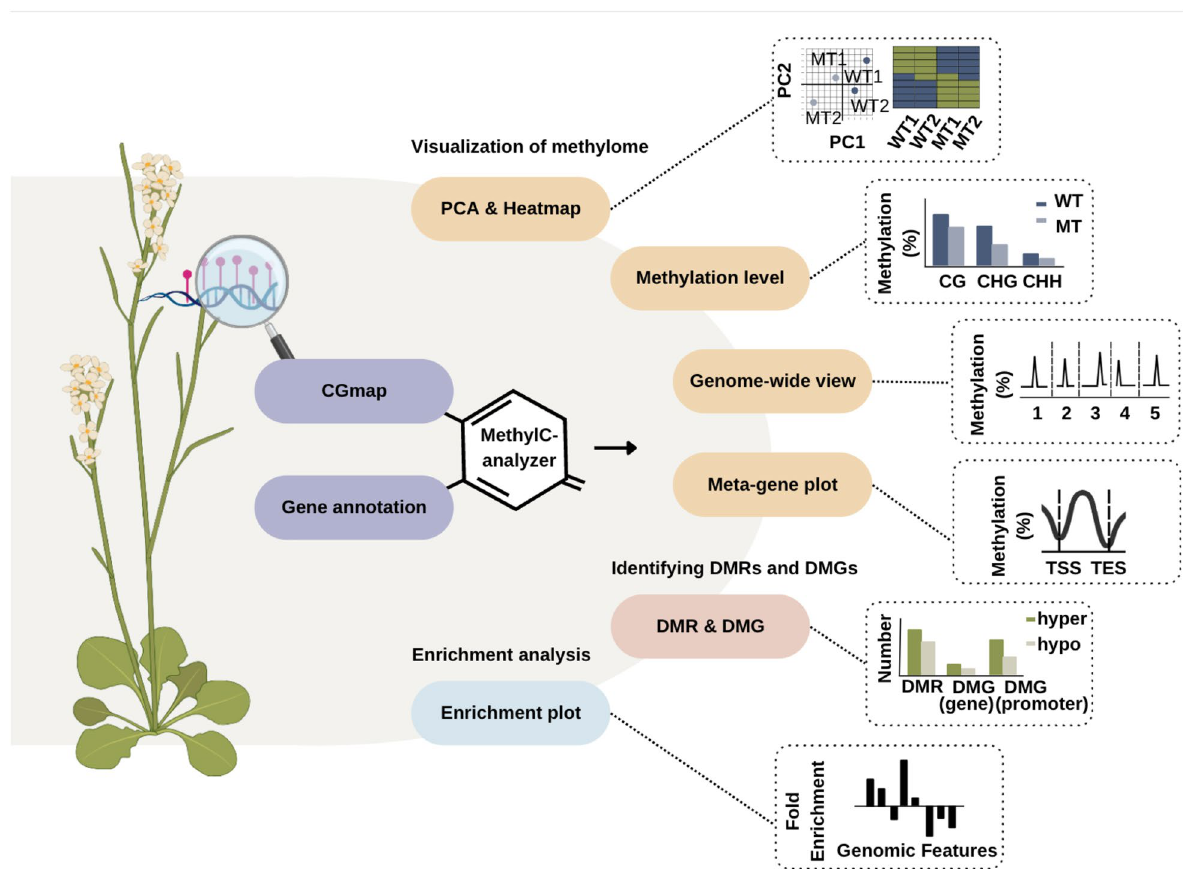
Fig. 1 Schematic diagram of MethyC‑analyzer. MethylC‑analyzer is a sequential pipeline for analyzing post‑align BS‑seq. To run MethylC‑analyzer, users provide a description text file with post‑alignment methylation summaries for each cytosine site of samples, e.g. CGmap and gene annotation file (GTF). The first step MethylC‑analyzer is to generate summary methylome figures of CG, CHG, and CHH context, including PCA, heatmap, and the distribution of methylation in each chromosome and gene‑centric manner. The following is to perform differential methylation analysis between two groups, for example, identifying differential methylation regions (DMRs) and its related genes (DMGs). Also, comparing methylation status around specific regions, such as gene bodies and promoters. Moreover, to survey the DMR enrich status at specific genomic feature regions (i.e., gene bodies, promoters, exons, introns, S’UTR, 3’UTR, IGR.); The last step is to visualize the above analyses, MethylC‑analyzer will